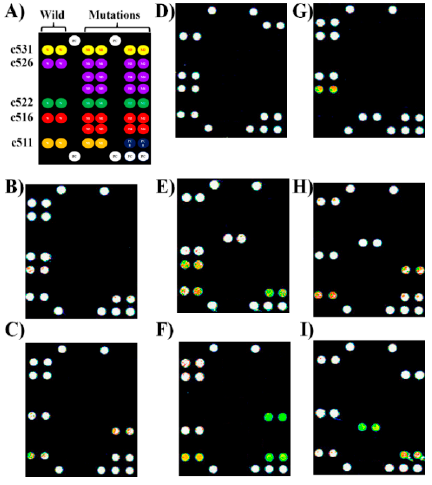
Figure 2. Multiplex detection of mutation in the multiple codons of the rpoB gene of TB in the clinical samples by rifampicin-resistant M. tuberculosis (MDR-TB-RIF) 9G DNAChip. ( A ) Scheme depicting the positions of immobilized probes; ( B ) Wild sample; ( C ) c516 (GAC Ñ GTC); ( D ) c531(TCG Ñ